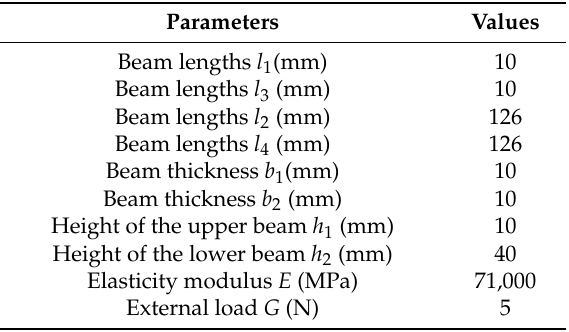
Table 3. Structural sizes of the two-stage flexural hinge lever-type mechanism.